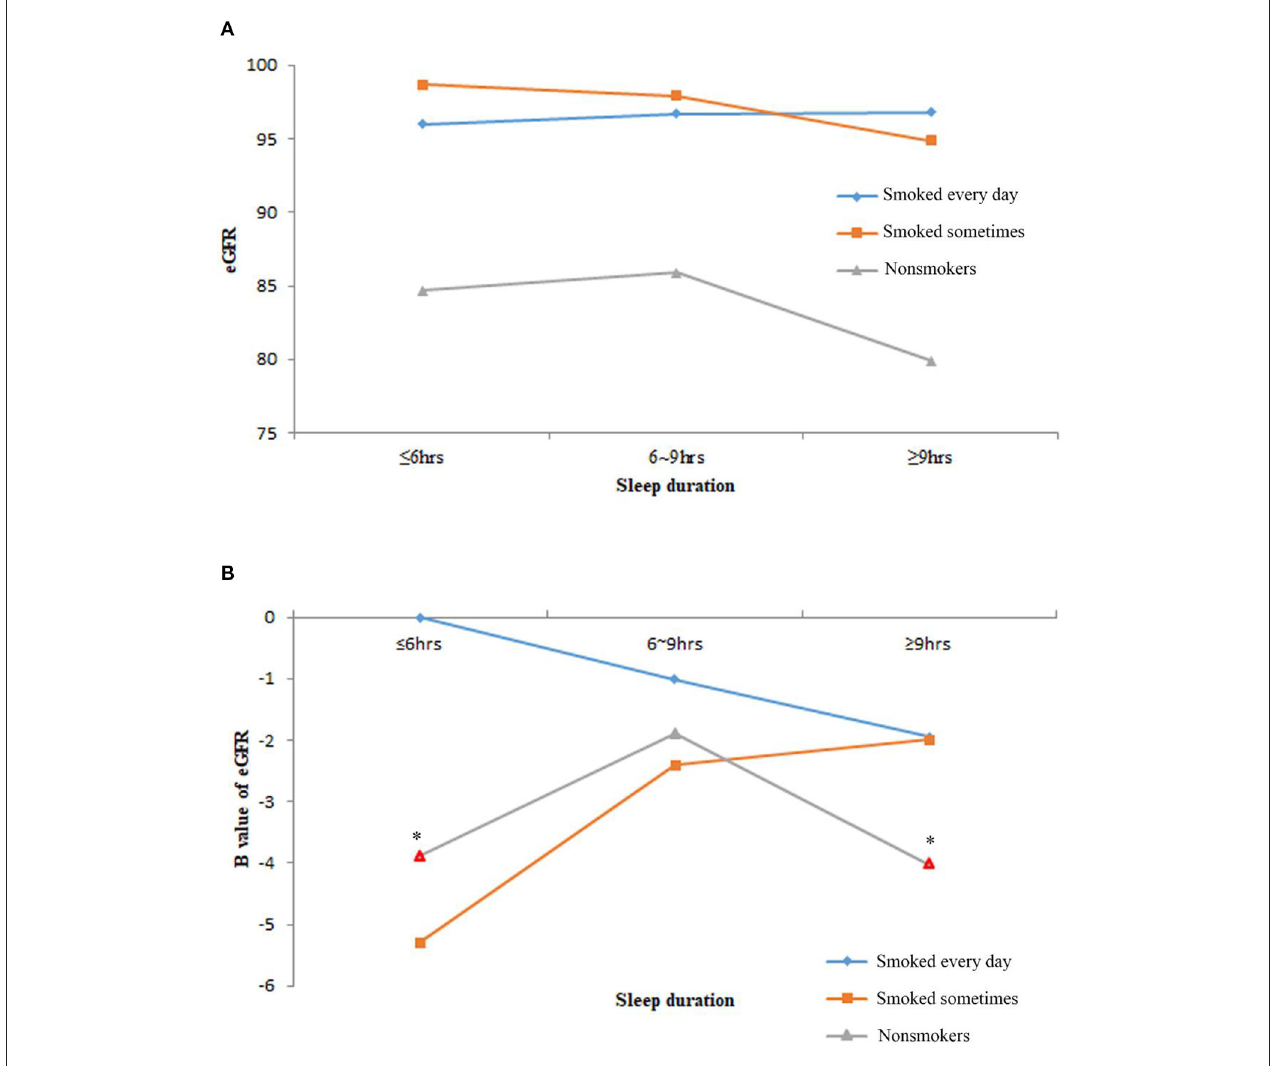
FIGURE 2 | The estimated glomerular filtration rate (eGFR) levels of the nine subgroups of study population by sleep duration and smoking frequency. (A) The average eGFR levels of nine subgroups. (B) The B value of eGFR in multivariable linear regression models after adjusting age, race, body mass index (BMI), marital status, frequency of snoring or breath cessation, diabetes, high blood pressure, high cholesterol, anemia, congestive heart failure, coronary heart disease and stroke. Marks in red border and asterisks denoted p < 0.05 in the multivariable linear regression